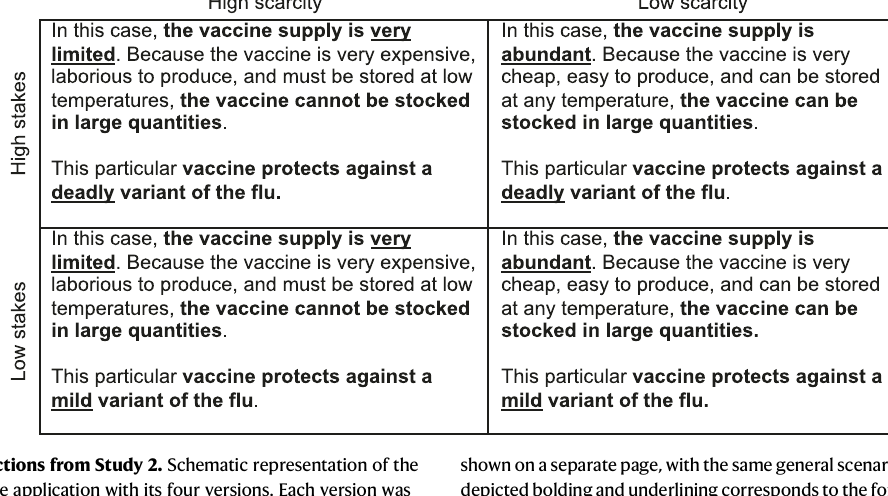
Fig. 2 | Exemplary instructions from Study 2. Schematic representation of the instructions for the vaccine application with its four versions. Each version was